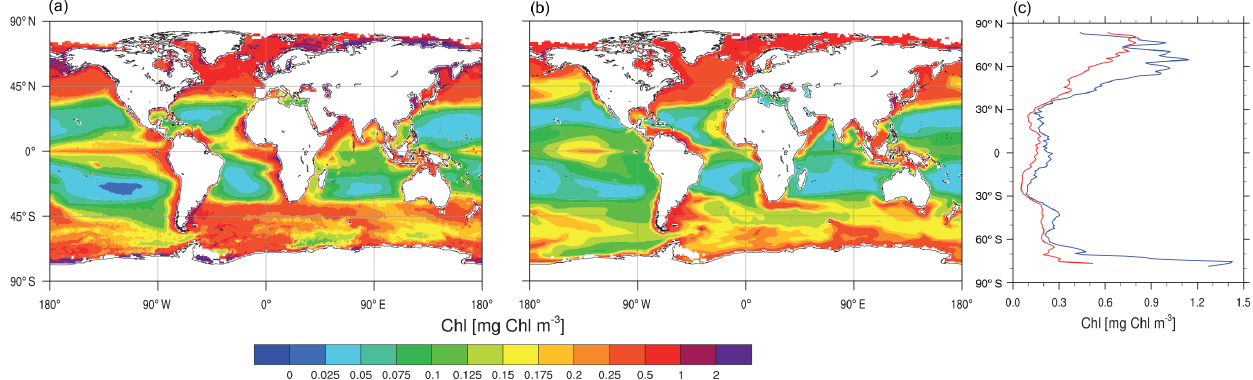
Figure 18. Annual-mean surface chlorophyll concentrations (Chl) as estimated from SeaWiFS over 1997–2010 (a) and as simulated by CNRM-ESM1 (b) over 1986–2005. Panel (c) represents the zonal-averaged Chl in function of latitude for both satellite-derived estimates (in blue) and CNRM-ESM1 (in